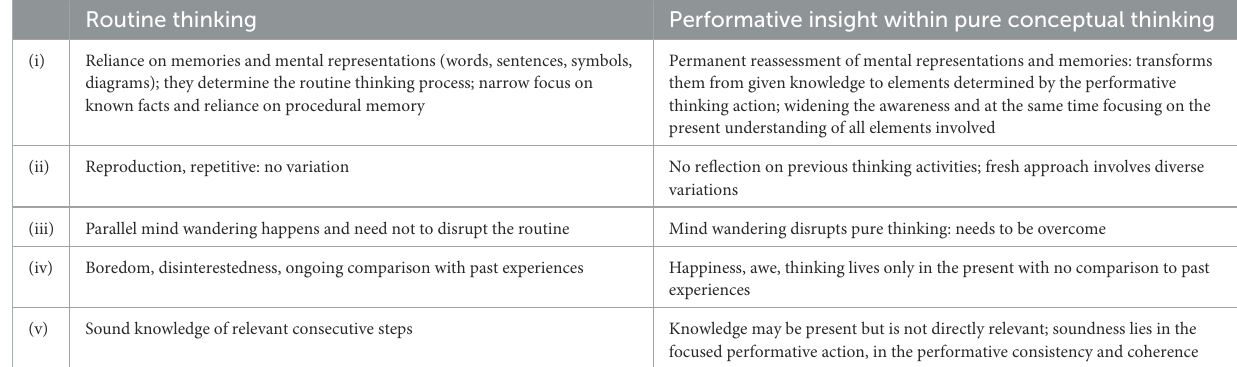
TABLE 2 Characteristics of the phenomenal contrast between routine thinking vs. focused productive thinking. Routine thinking Performative insight within pure conceptual